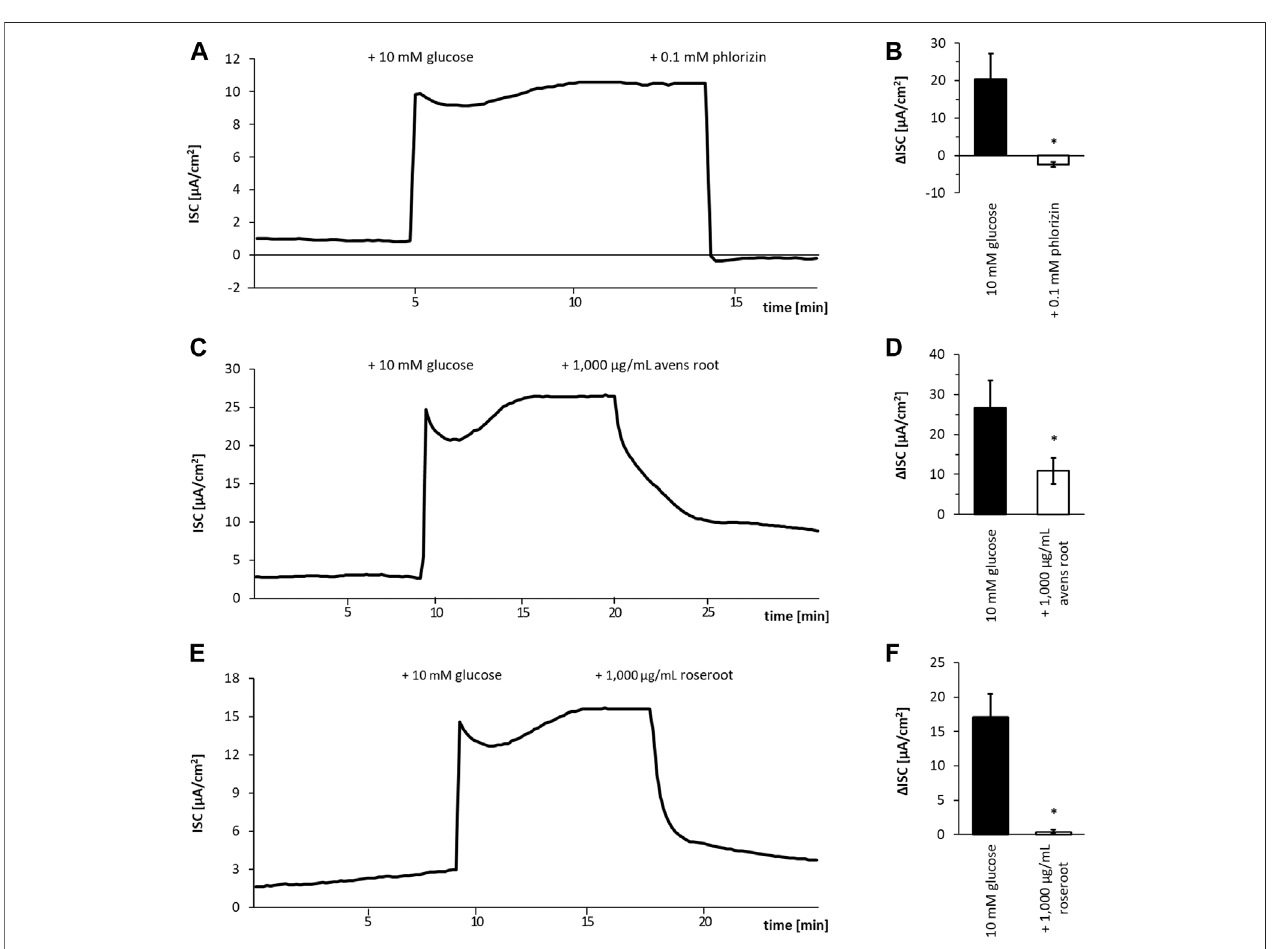
FIGURE 2 | In fl uence of root extracts on SGLT1-dependent glucose transport in Caco-2 cell monolayers. Caco-2/PD7 monolayers were mounted in Ussing chambersandtheshort-circuitcurrent(I SC )wasmonitoredovertime.Exemplaryrunsaredepictedin (A,C,E) .Theadditionofglucose(10 mM)totheapicalsideledtoa fastincreaseoftheI SC .AftertheI SC hasreachedastableplateau(approximately10 minafterglucoseaddition),1,000 μ g/mlavensrootextract (A) 1,000 μ g/mlroseroot extract (C) orphlorizin(0.1 mM) (E) aspositivecontrolwasadded.ThecorrespondingcalculatedI SC valuesareshownin (B,D,F) .Errorbarsindicate thestandard error of the mean. All experiments (n (cid:2)